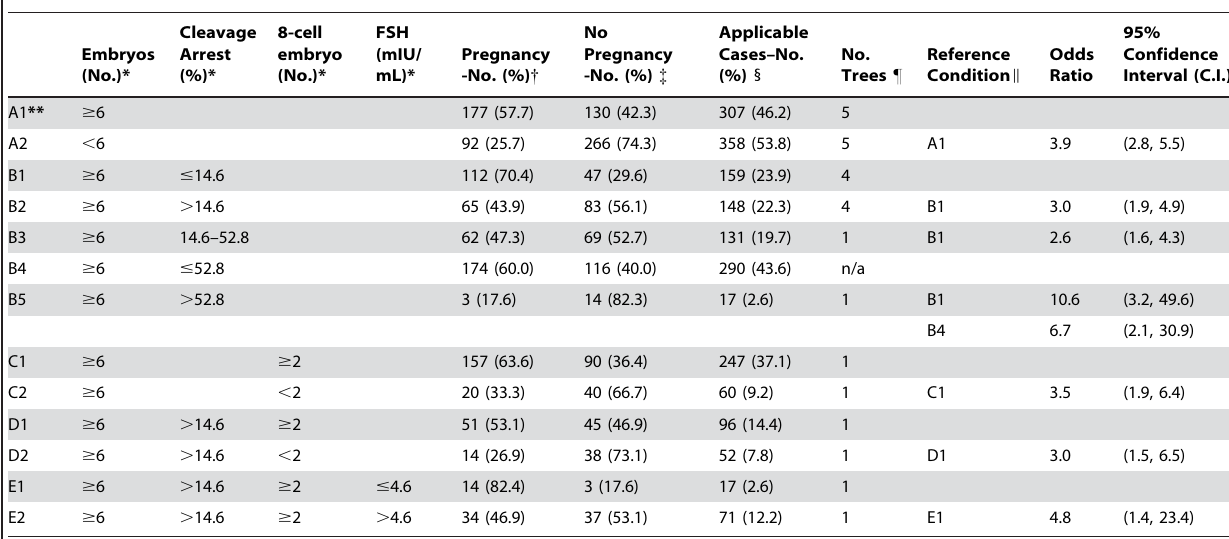
Table 2. Prognostic thresholds defining cohort-specific phenotypes.